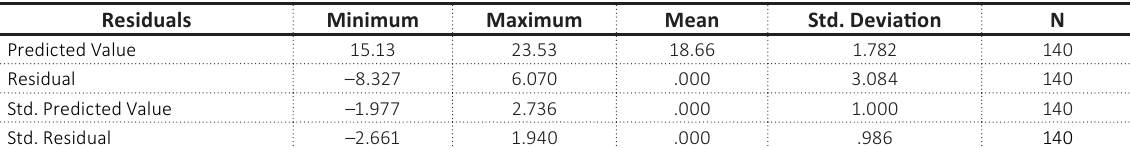
Table 9. Residuals statistics